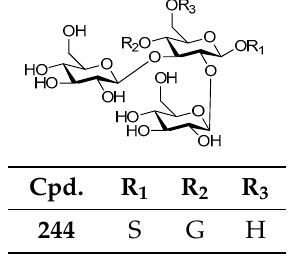
Figure 50. Structure of compound 244 .